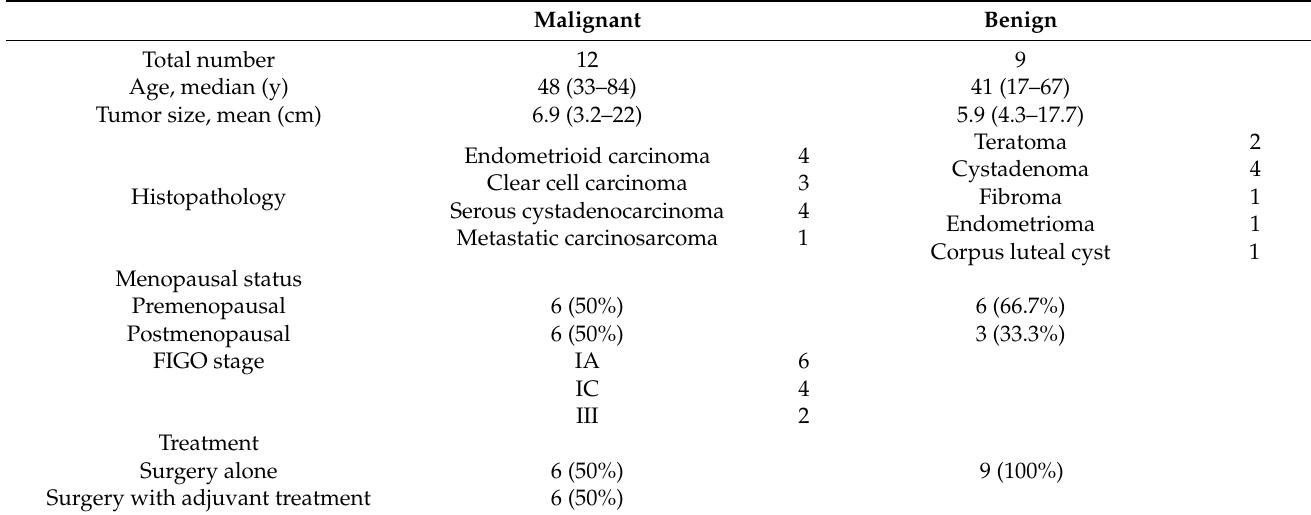
Table 1. Demographics of the study participants.